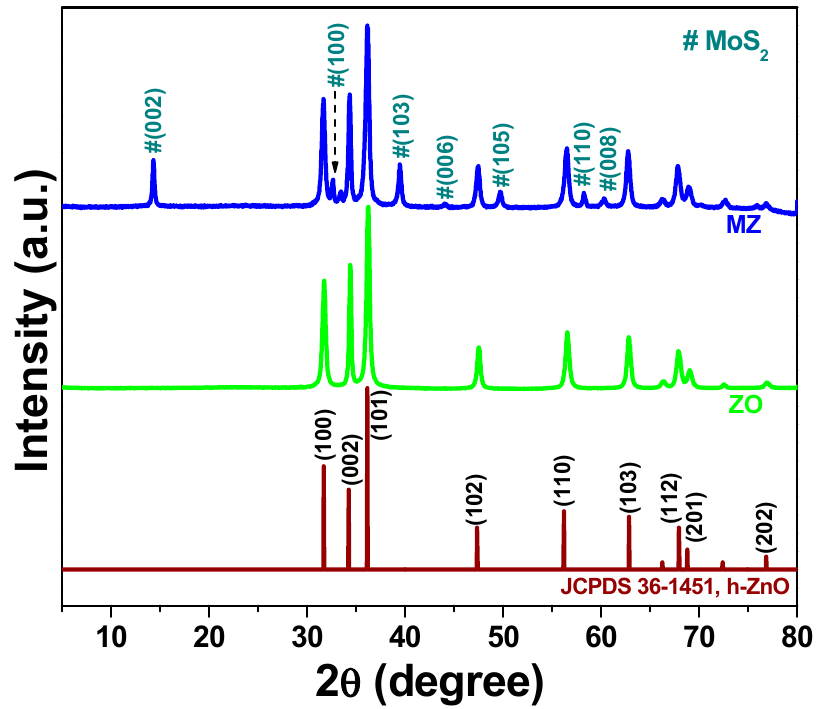
Figure 1. X-ray diffraction (XRD) patterns of ZO and MZ samples.